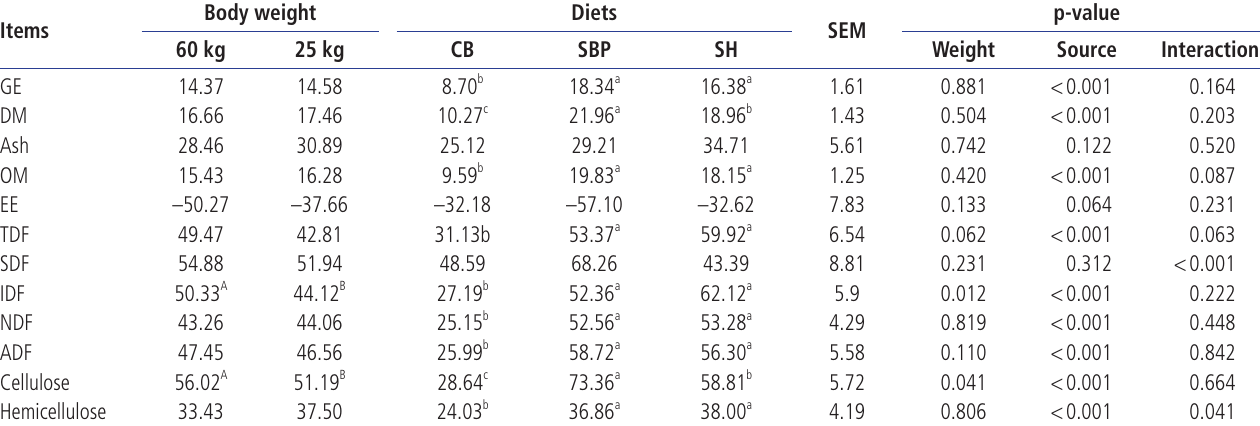
Body weight Diets